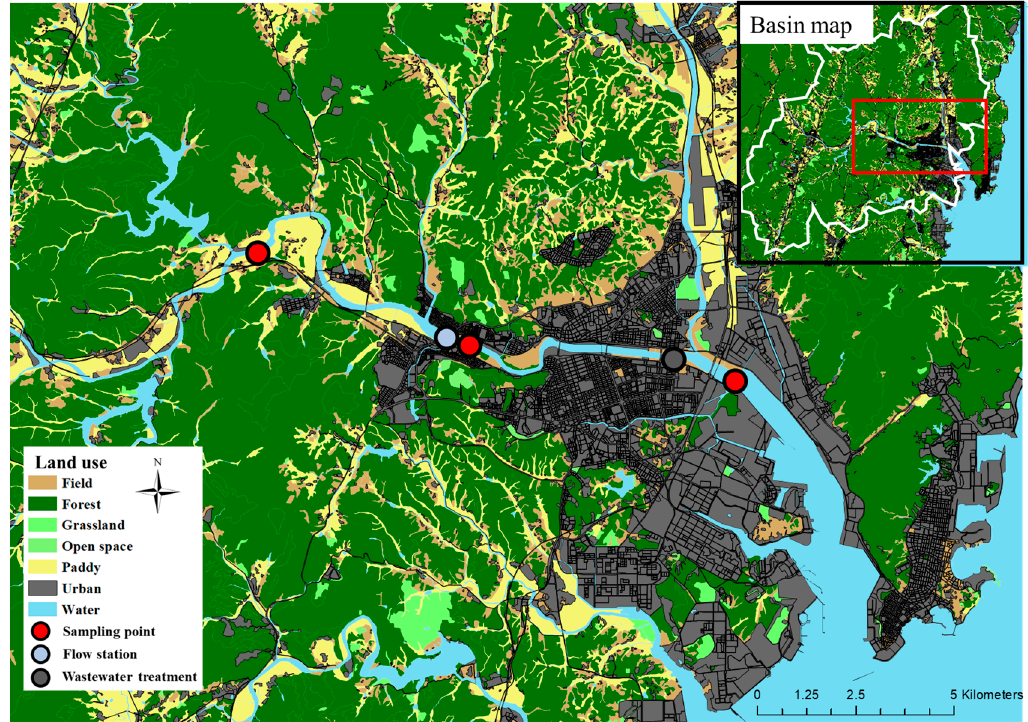
Figure 1. Sampling points in the Taewha River in Ulsan City,